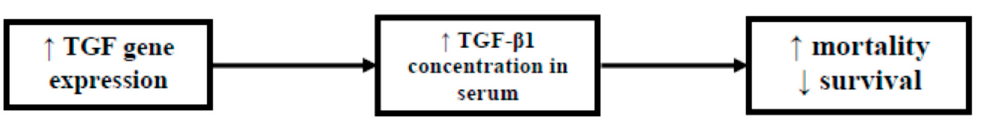
Figure 2. Relationship between changes in TGF gene expression and longevity.